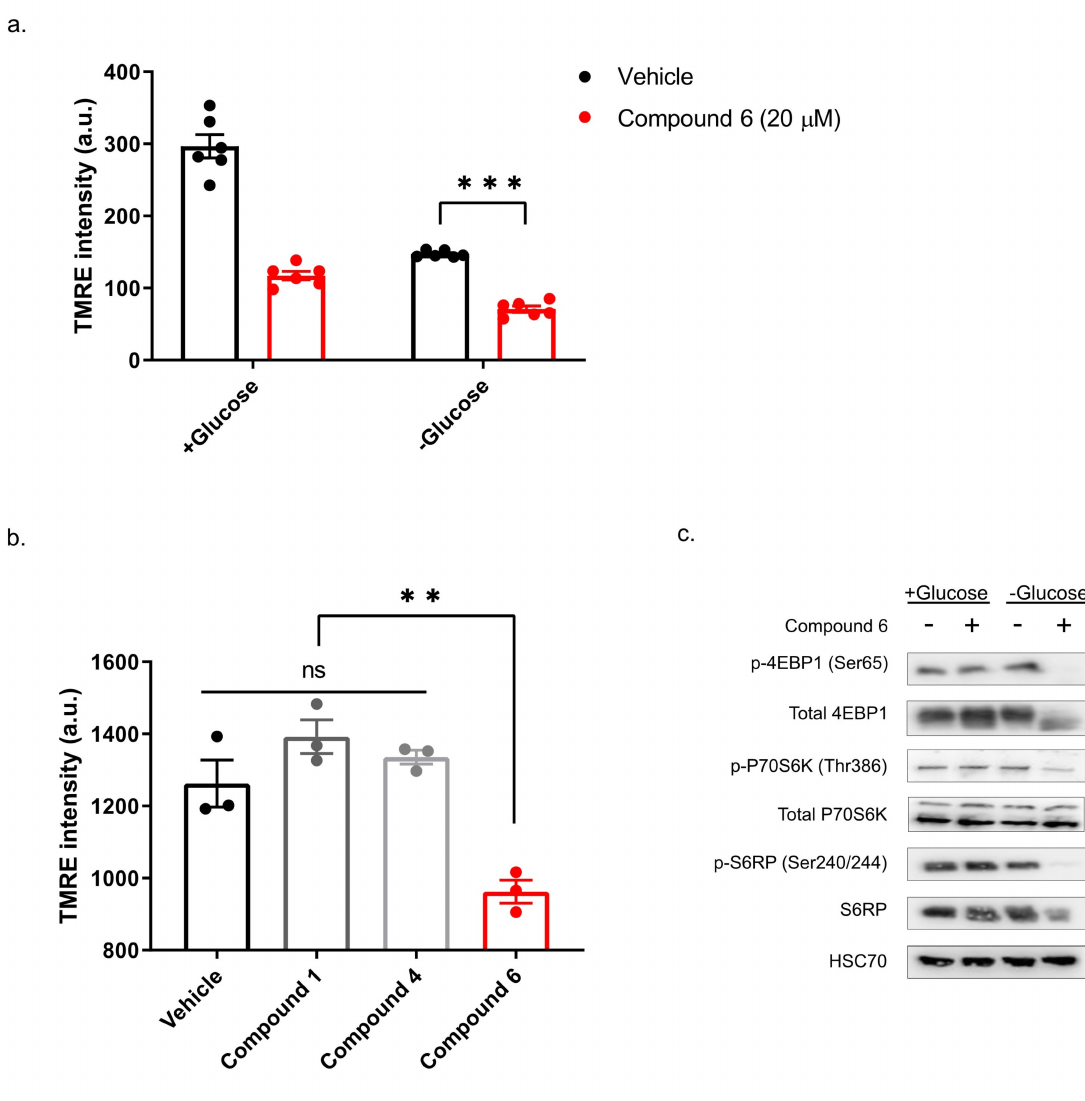
Figure 5. Compound 6 significantly reduced mitochondrial membrane potential. ( a ) The mitochondrial activity in DLD1 cells was measured by tetramethylrhodamine, ethyl ester (TMRE) and FACS. DLD1 cells were treated with compound 6 (20 µ M) (red), or vehicle (black) (the same volume of DMSO) for three hours with and without glucose. a.u. = arbitrary units. *** p < 0.0001. ( b ) Mitochondrial activity of DLD1 cells treated with vehicle (black) or 10 µ M of compounds 1, 4 (grey) and compound 6 (red) for 3 h. ** p < 0.01. ( c ) Inhibition of the mTOR pathway in U251 cells treated with compound 6 (10 µ M) for 3 h in the presence or absence of glucose, after which cell lysates were collected and analyzed by immunoblot using the indicated